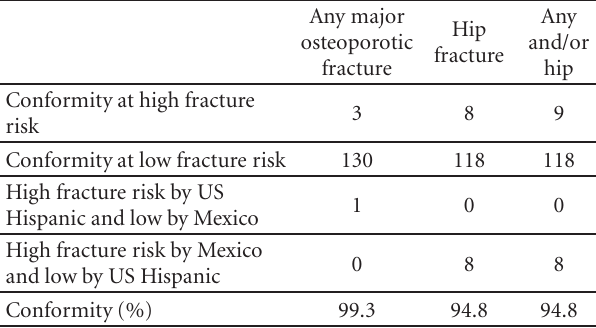
Table 3: Conformity of risk assessment between US Hispanic and Mexico FRAX databases for women of Mexican